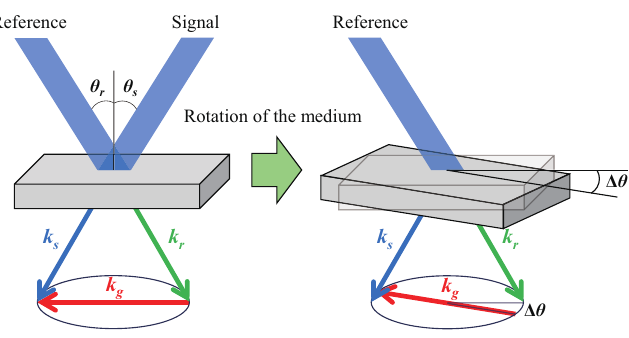
Figure 2. Principle of the peristrophic